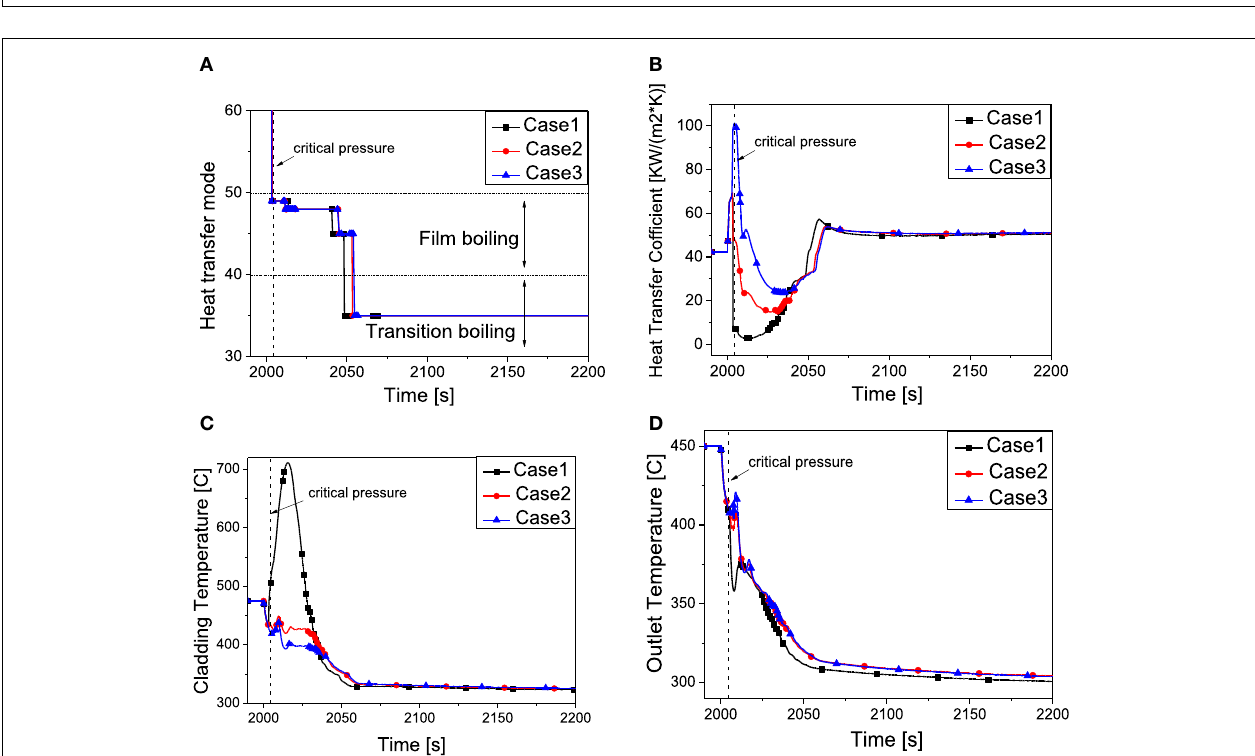
FIGURE 10 | System behavior by the effect of HTC to vapor . (A) Heat transfer mode. (B) Heat transfer coefficient. (C) Peaking cladding temperature. (D) Core outlet temperature.